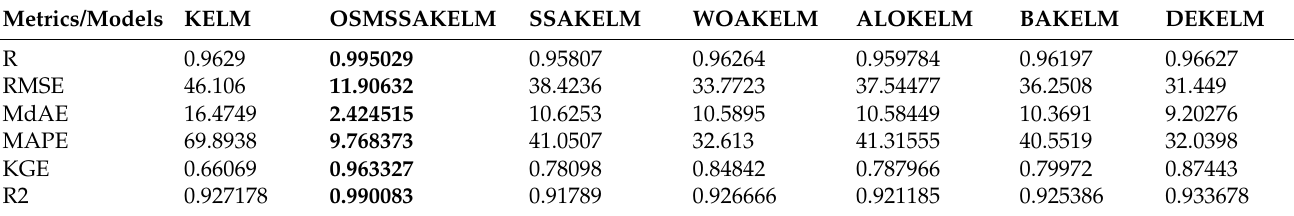
Table 4. Comparison of the average testing results for different optimized KELM